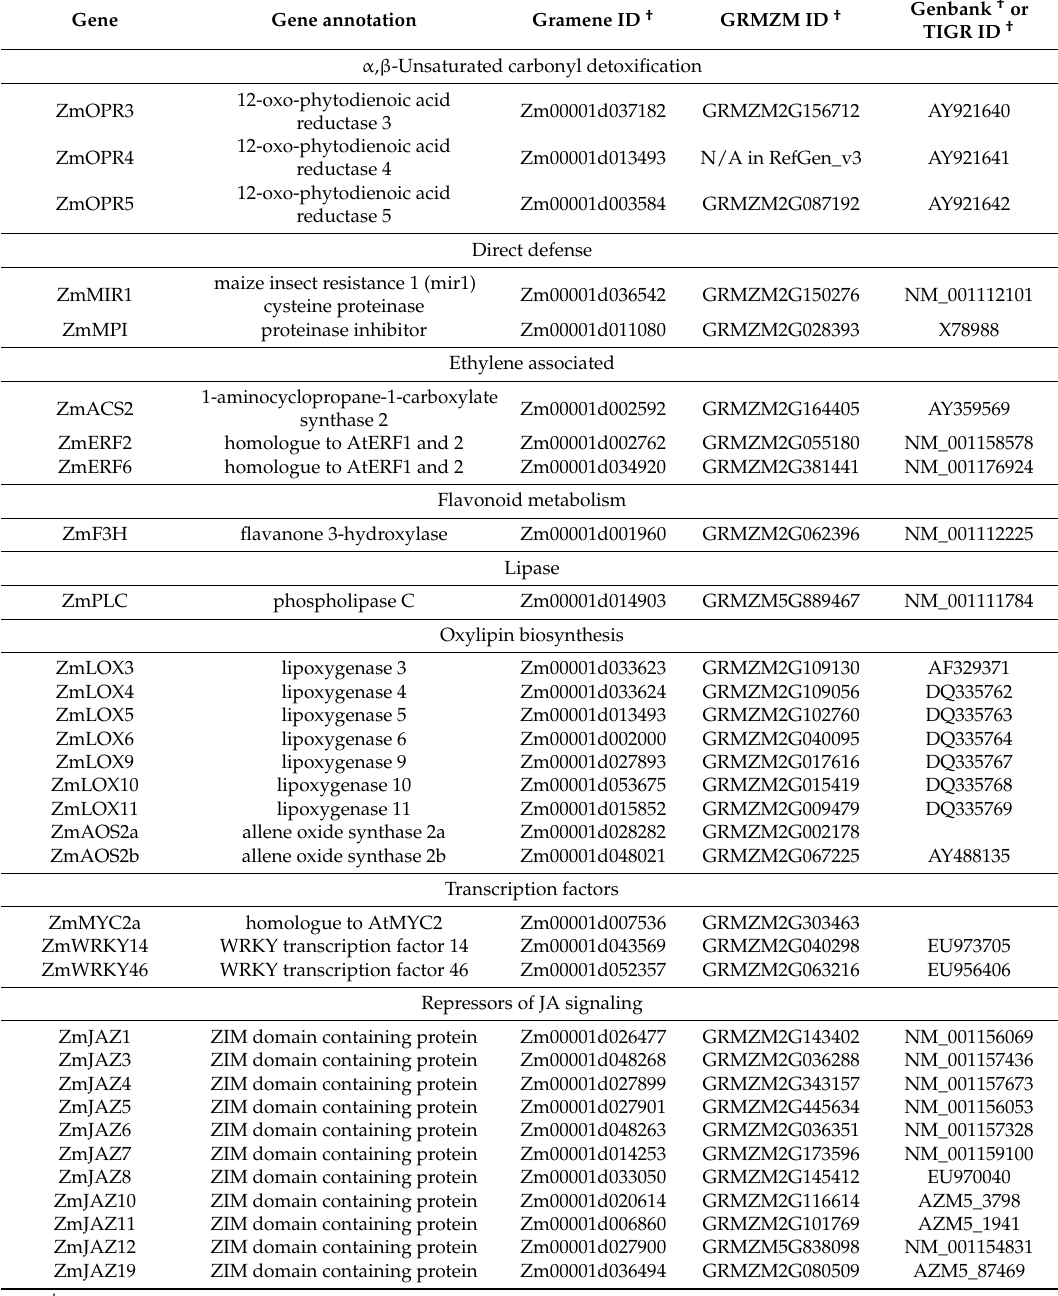
Table 1. JA-dependent wound-responsive genes, adapted from